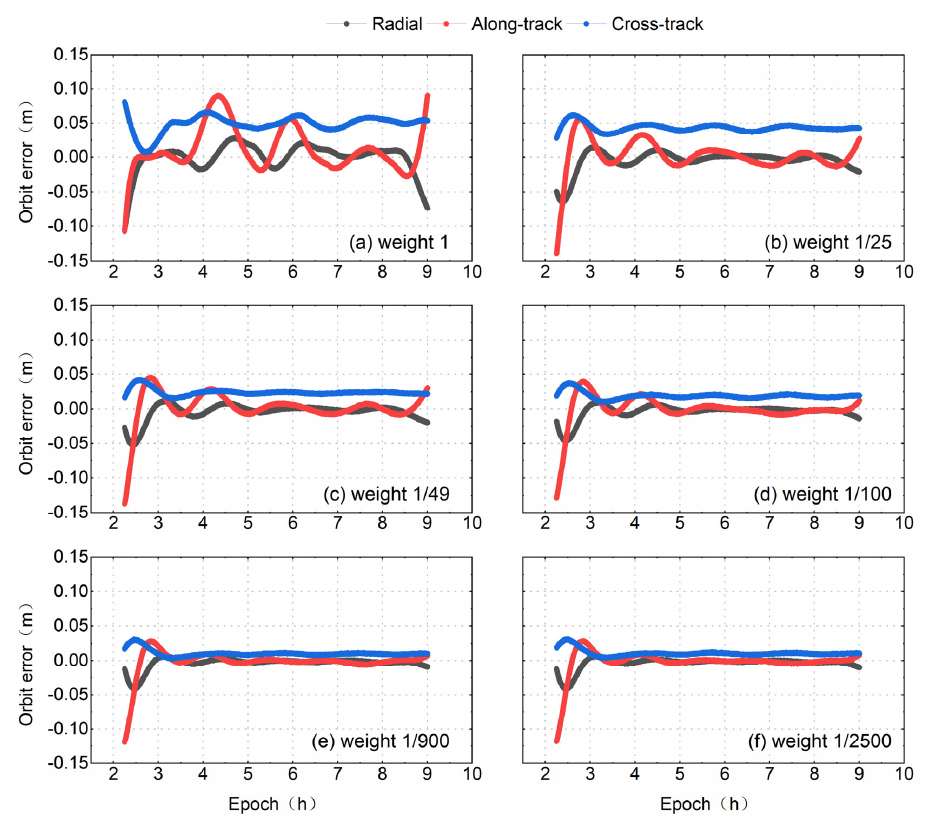
Figure 9. Orbit error of Luojia-1A in different scenarios.